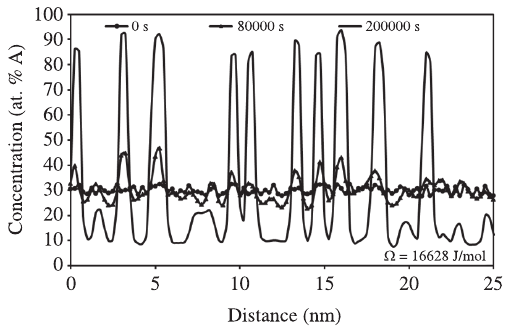
Figure 4. Concentration profile of the A-30at.%B alloy aged at 650 K for different times for Ω